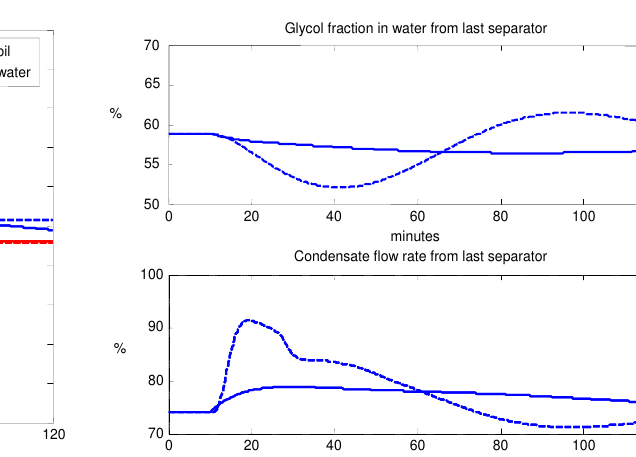
Figure 6: Glycol concentration in glycol/water mixture (top) and oil flow rate (bottom) from the last stage separator, with MPC (solid) and with- out MPC